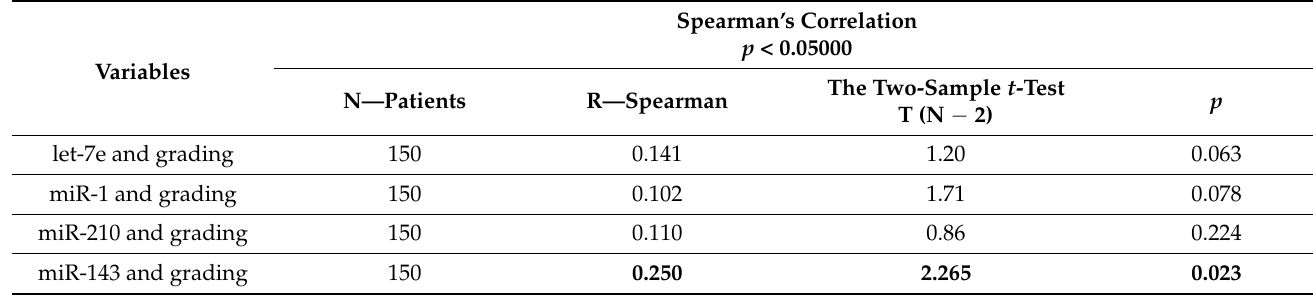
Table 6. Correlation between studied miRNA and the degree of tumor differentiation (grading).